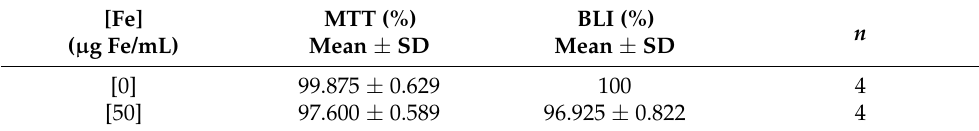
Table 1. MSC cellular viability in MTT and BLI assays following